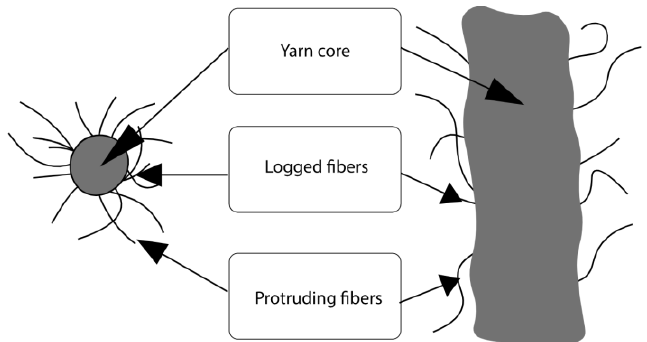
Figure 11. Representation of the yarn core and fibers (Adapted from [17]).